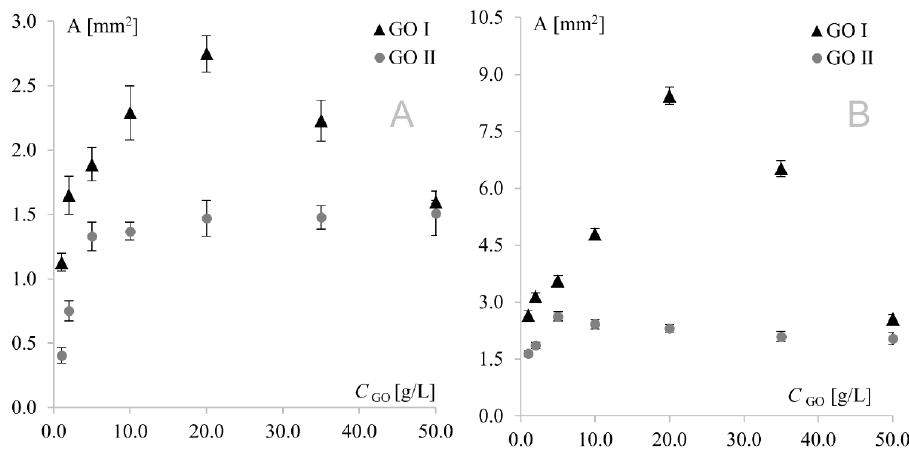
Figure 5. Electroactive surface of Au ( A ) and Pt ( B ) electrodes modified with GO I and GO II.